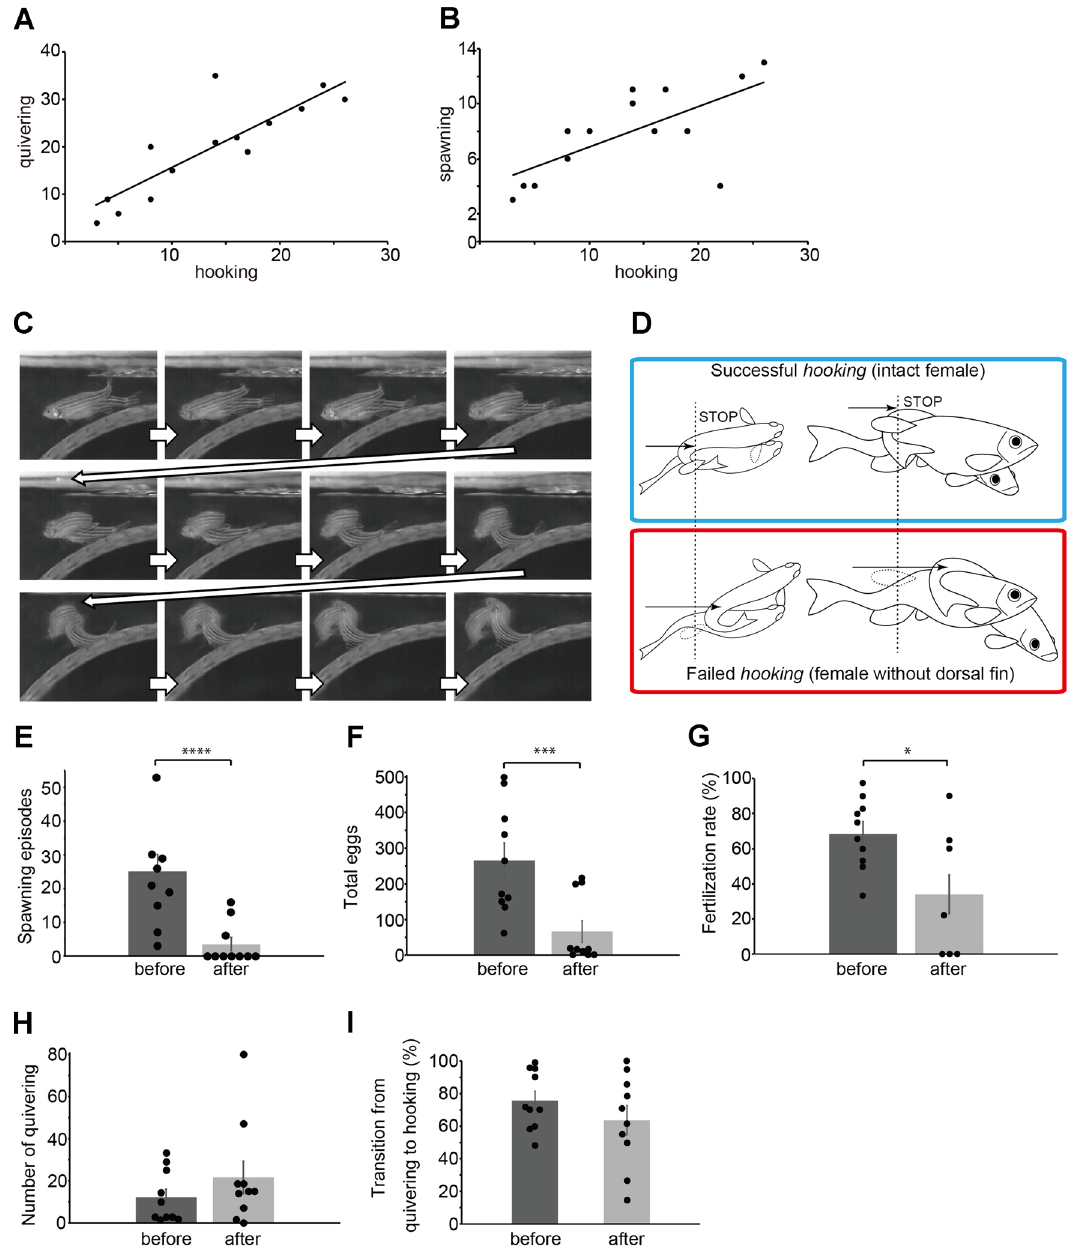
Figure 2. Functional significance of hooking behavior. ( A ) The numbers of quivering plotted against those of hooking . (r = 0.85, p = 0.00010). ( B ) The numbers of spawning plotted against those of hooking (r = 0.68, p = 0.0069). ( C ) Photographs showing mating behavior of an intact male and a female with its dorsal fin removed. The female is behind the male in the initial frame. The trunk of the male slips rostrally without switching to squeezing . ( D ) Illustrations showing typical hooking behavior of a WT intact pair (upper blue box), and the WT pair with the female fin removal (lower red box). ( E ) Identified episodes of spawning before and after the fin removal ( p = 0.00088, t-score = 3.98, n = 10). ( F ) Total number of released eggs before and after the fin removal ( p = 0.0029, t-score = 3.44). ( G ) Fertilization rate before and after the amputation. Fertilization rate was significantly decreased after dorsal fin removal ( p = 0.027, t-score = 2.45). ( H ) Episodes of quivering before and after the fin removal ( p = 0.29, t-score = − 1.08). ( I ) The percentage of pairs proceeding from quivering to hooking (Note all hooking bouts finished incompletely after the fin removal, p = 0.27, t-score = 1.15). Regression lines are shown in ( A ) and ( B